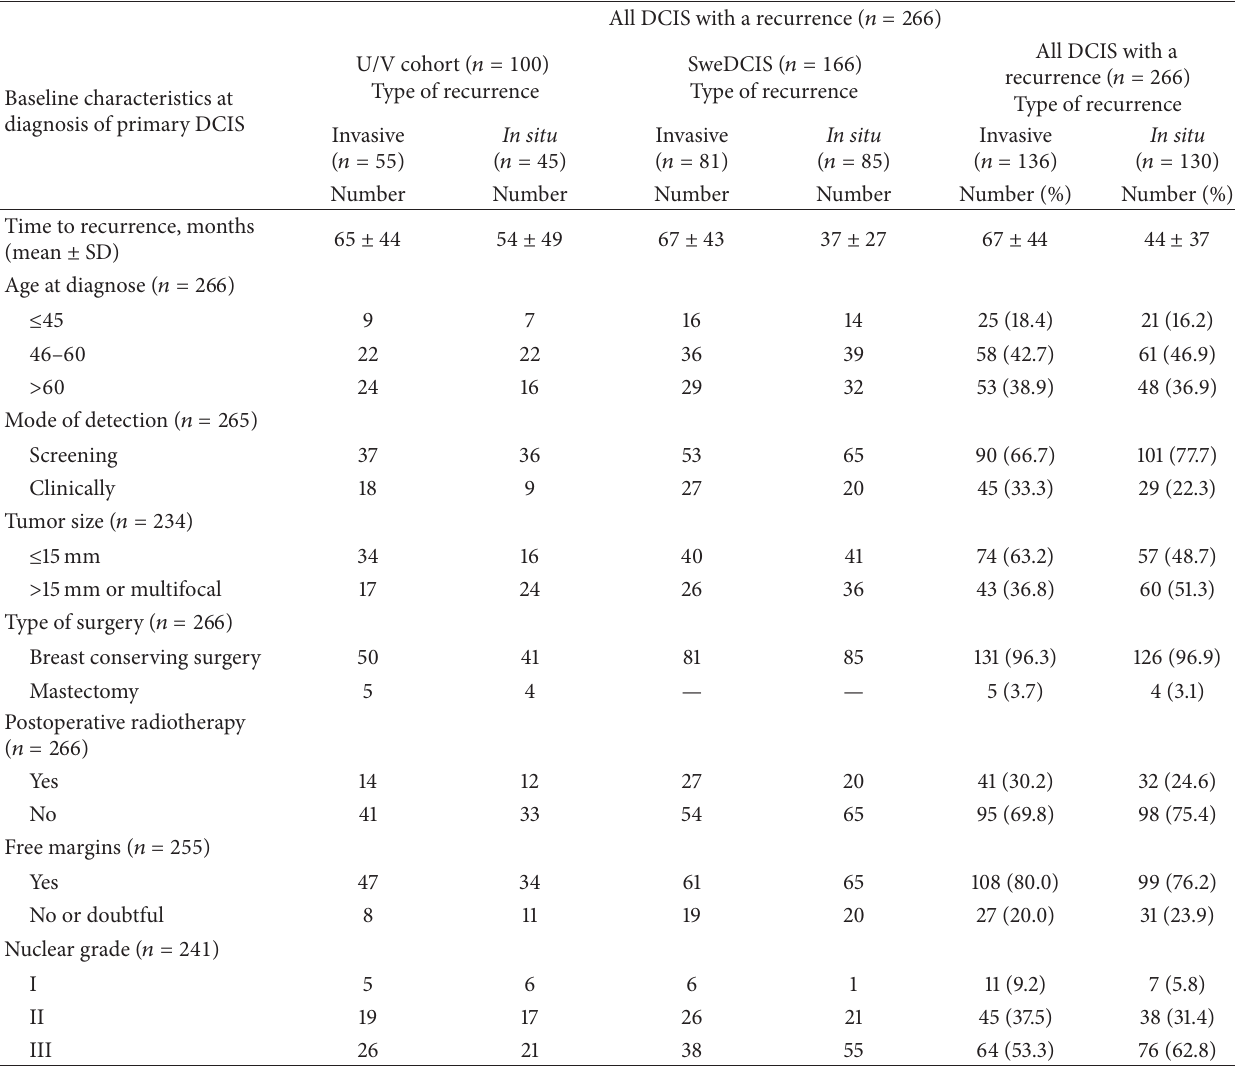
Table 1: Baseline clinical and histopathological characteristics among women with a primary DC44IS who later developed either an invasive cancer or an in situ recurrence. Women with a known recurrence were recruited from two source populations: a population based cohort (U/V cohort, 𝑛 = 458 ) and a randomized study (SweDCIS, 𝑛 = 1